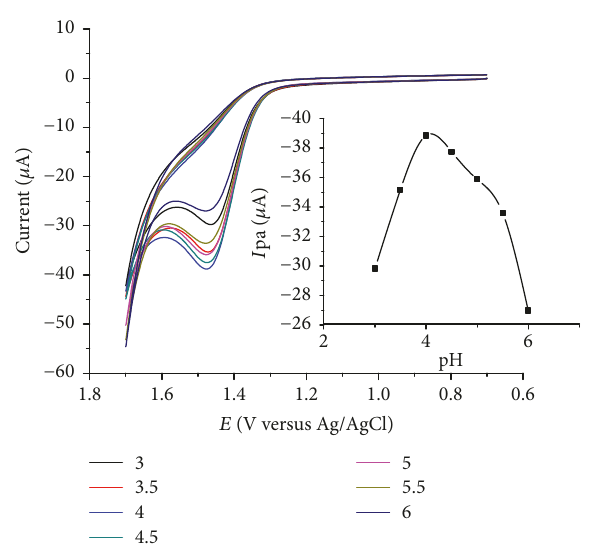
Figure 3: CVs of LGCE in ABS of different pH values (3.0–6.0) containing 1.0 × 10 −3 molL −1 of caffeine. Inset: plot of Ipa versus pH in pH range 3.0–6.0 at a scan rate of 100mVs −1 .